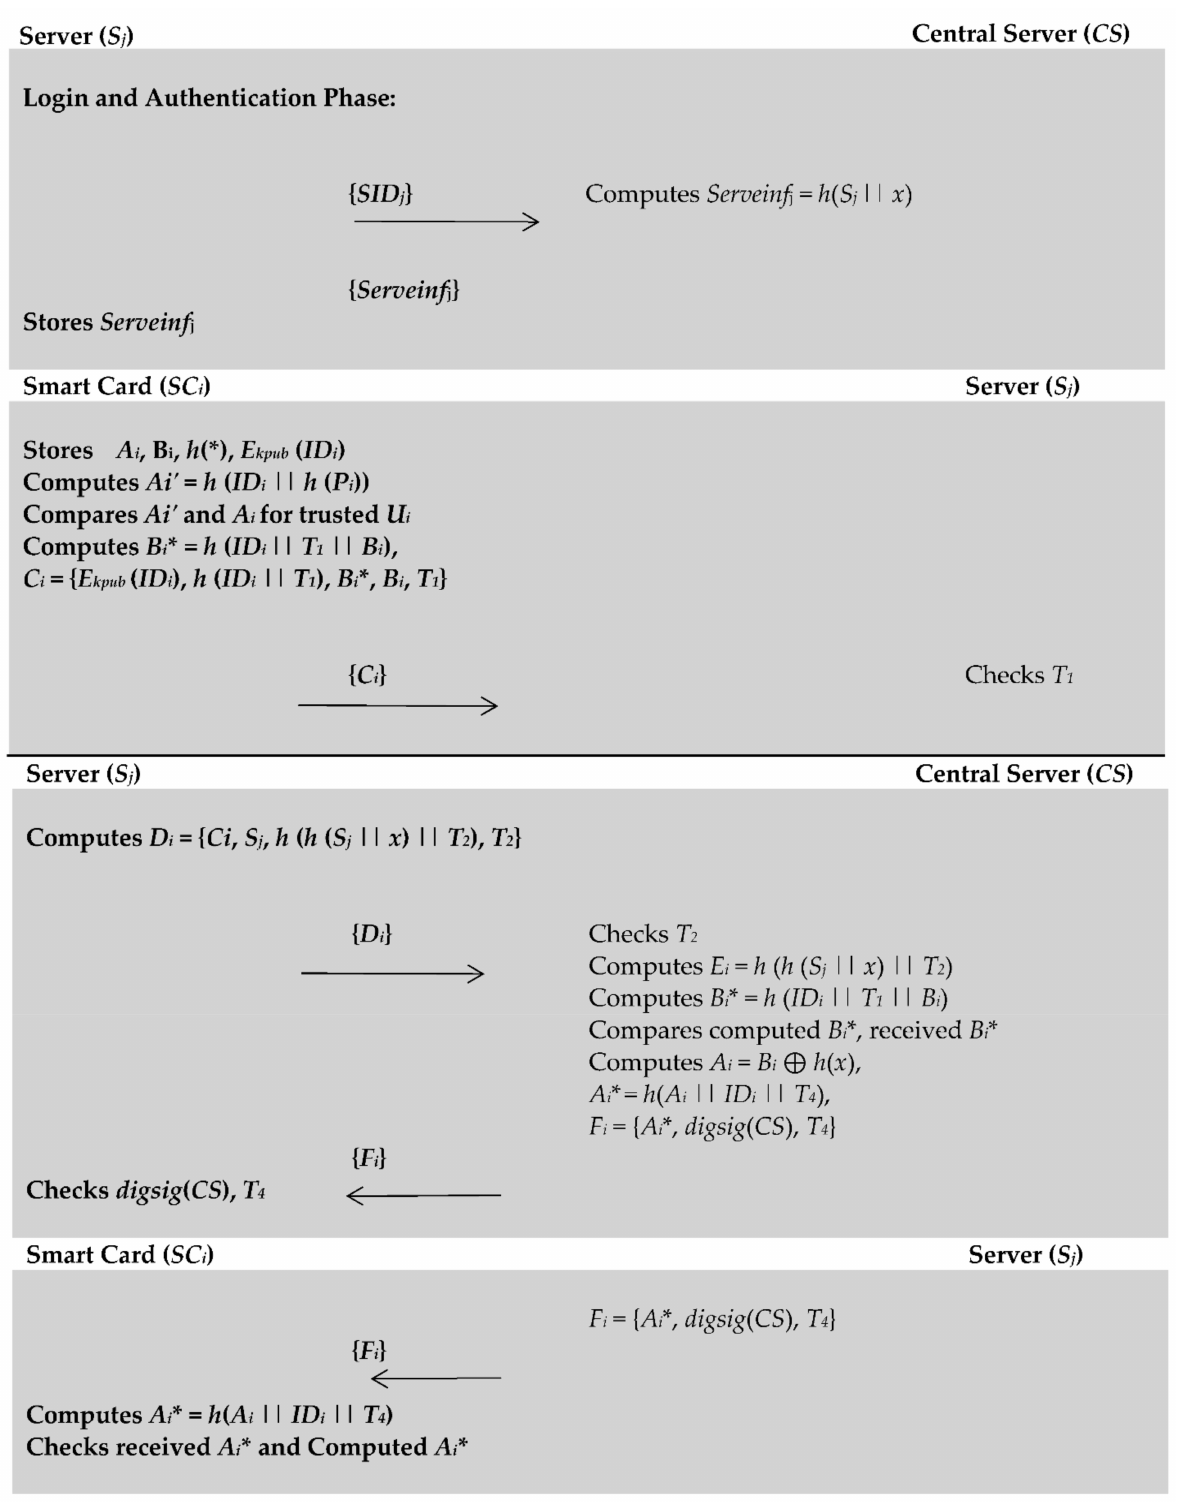
Figure 2. Login and Authentication